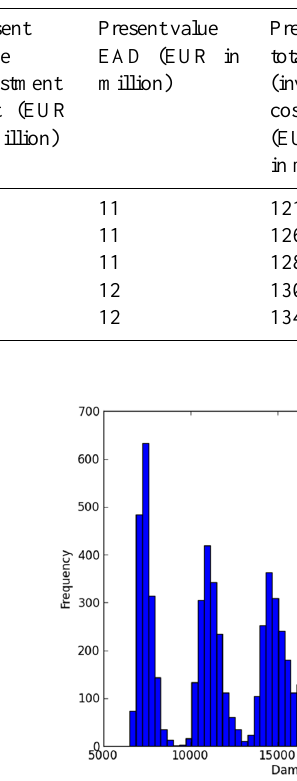
Figure 6. Frequency distribution of the damage in the case study area (based on 10000 Monte Carlo simulations). The five peaks represent the six models used in this study, with two models over- lapping. The damage has the price level of